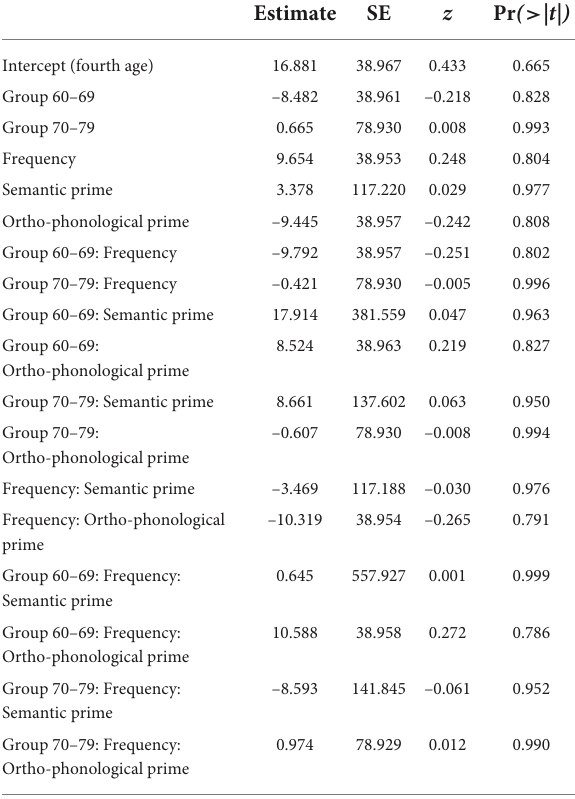
TABLE 4 Generalized linear mixed-effects regression accuracy results for Experiment